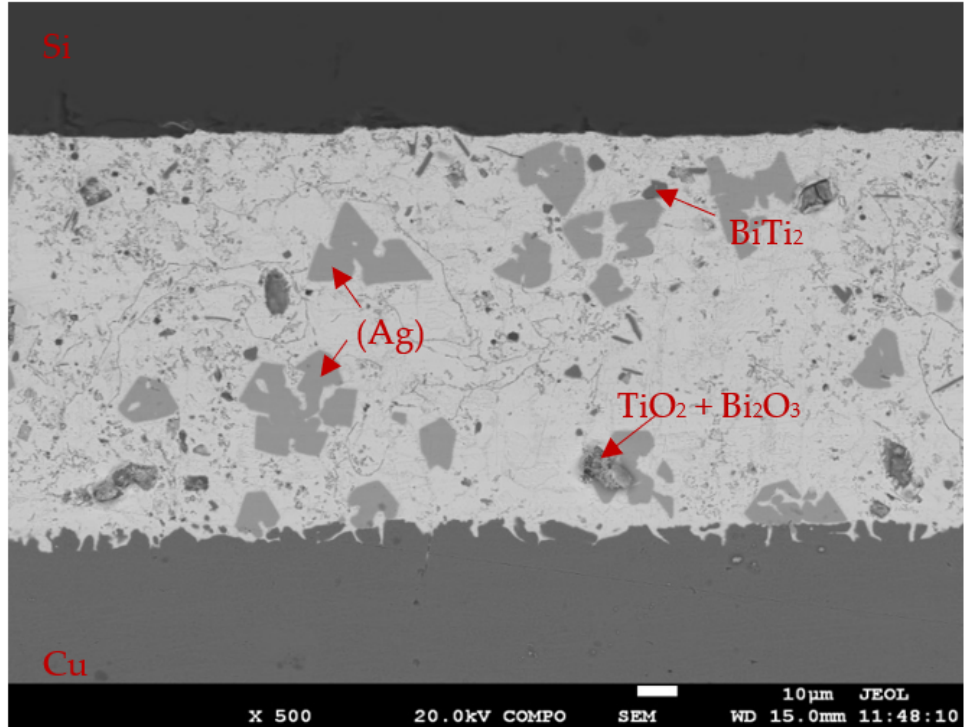
Figure 11. Microstructure of boundary in Si/Bi11Ag1.5Ti/Cu joint from SEM in BSE (backscattered electron) mode.